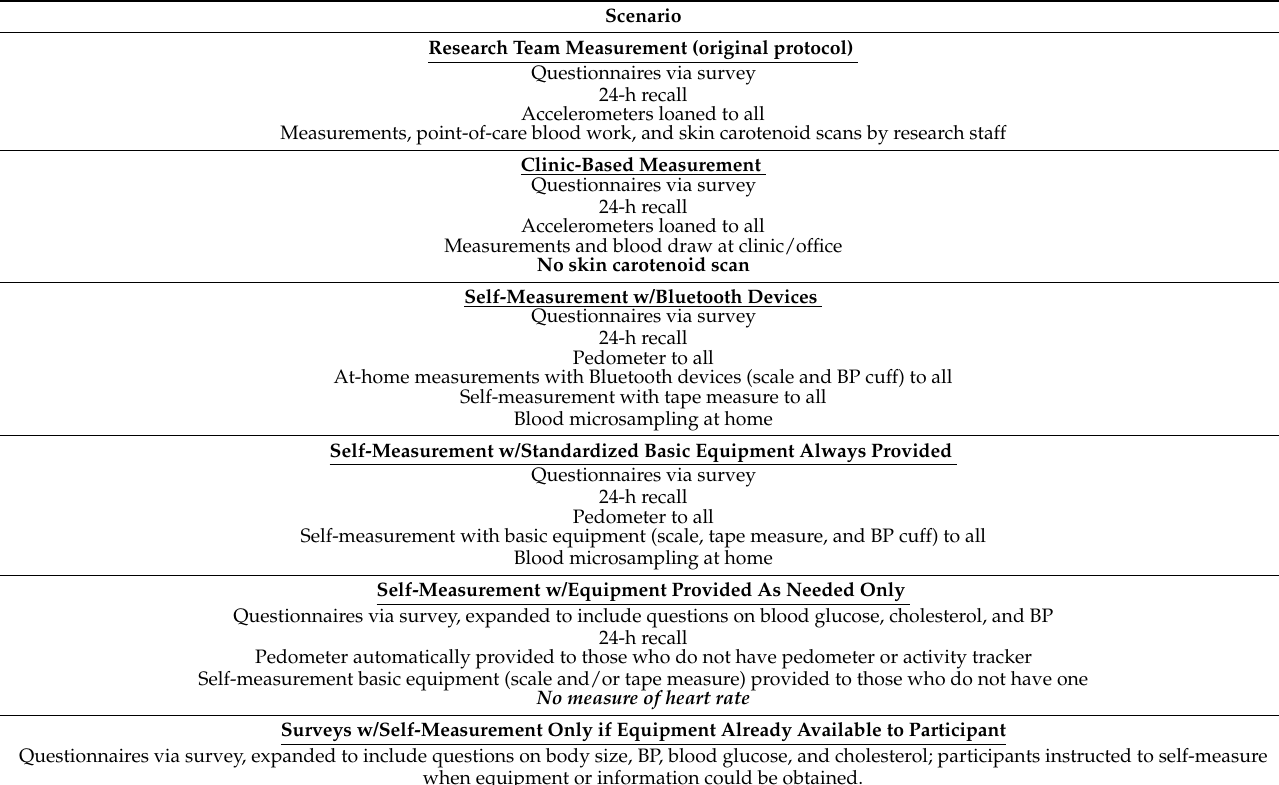
Table 2. Six data collection